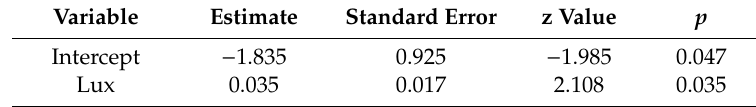
Table 3. Generalized linear model explaining the occurrence of nocturnal foraging by Feral Pigeons ( Columba livia f. domestica ) in Buenos Aires and Salta, Argentina.